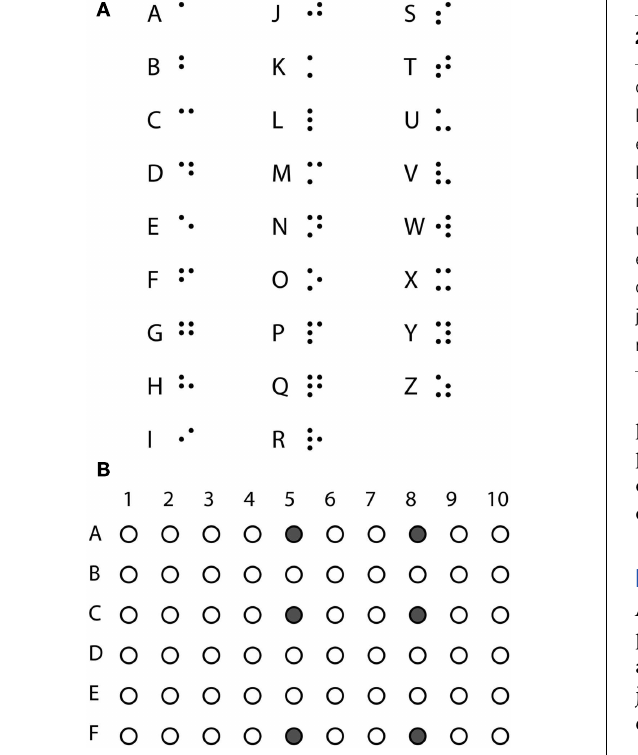
performance was not dependent on a narrow parameter range,the experiments were repeated with 40 and 60 Hz stimulation.